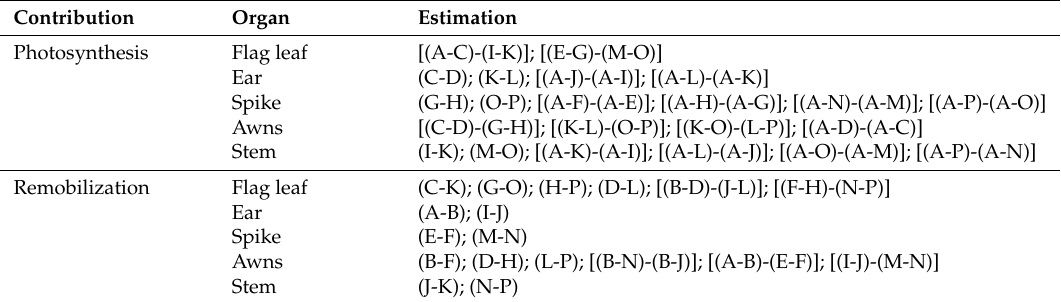
Table 6. Relative contribution of photosynthesis and re-mobilization of the different organs of durum wheat to the grain filling. Letters in column at right are the treatments (see Figure 4 for